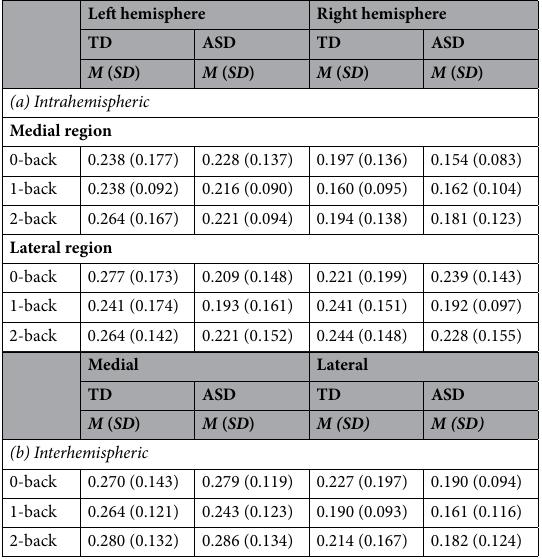
Table 3. Connectivity measures indicating (a) intrahemispheric and (b) interhemispheric functional connectivity in the lateral and medial prefrontal cortex during the n-back task in TD (n = 24) and ASD (n = 22) individuals.